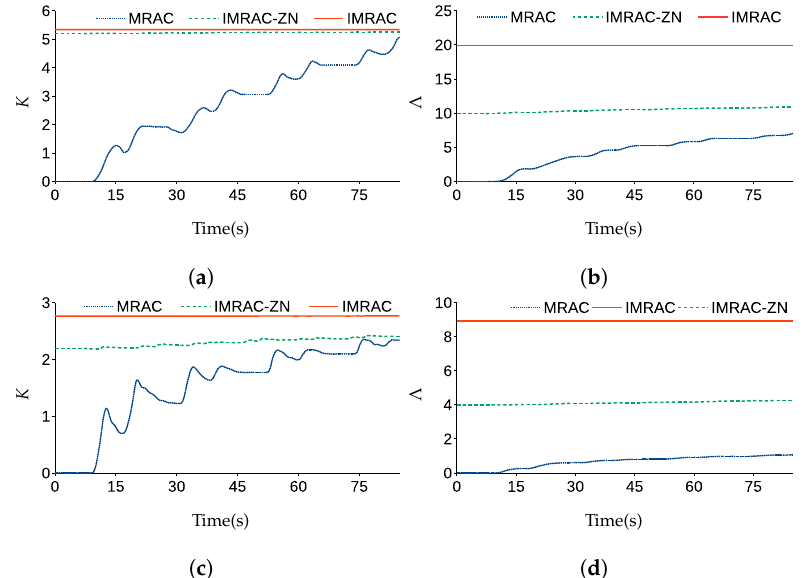
Figure 11. Changes in controller gains. ( a ) K for hip; ( b ) Λ for hip; ( c ) K for knee; and ( d ) Λ for